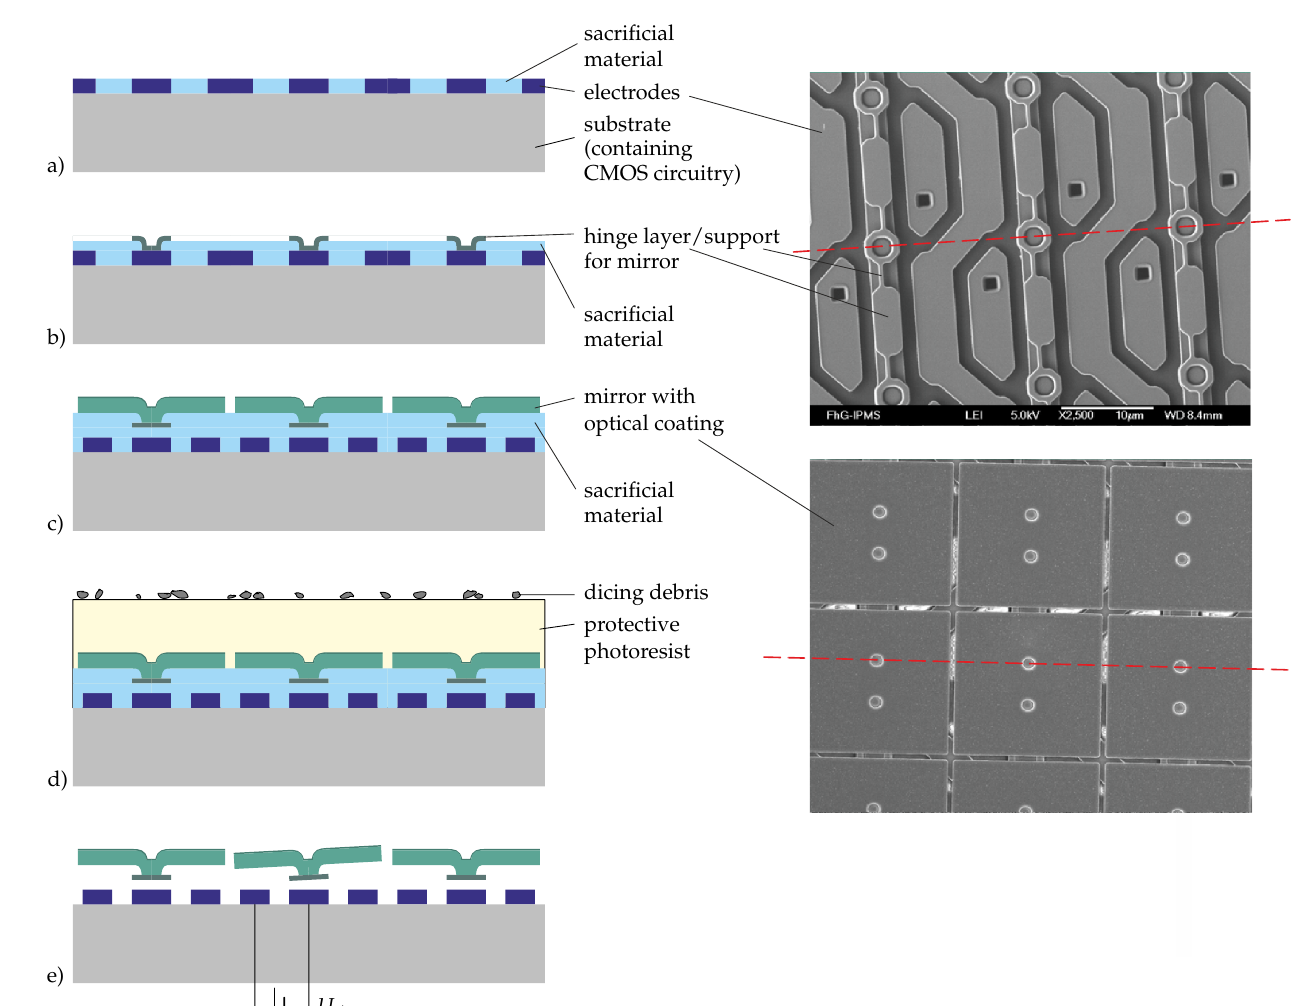
Figure 5. Fabrication of micromirror arrays: on the left, drawings of cross-sections indicating the main steps of the fabrication are shown; on the right, there are SEM images of the electrode and hinge layers (top) and the mirrors (bottom); the red lines indicate the position of the cross-sections in the drawings (the line in the upper SEM image referring to ( a , b ) and in the lower one to ( c – e